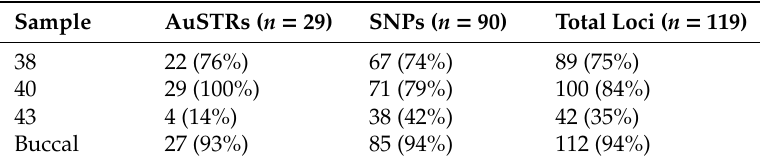
Table 3. The number of autosomal short tandem repeat (STR) and single nucleotide polymorphism (SNP) loci produced from three skeletal samples (38, 40 and 43) and Fides Kozuli´c’s buccal swab. Except for sample 40 (the bone control), each allele was replicated in two independent DNA extracts. The alleles produced from sample 40 were replicated in a second amplification event from the same DNA